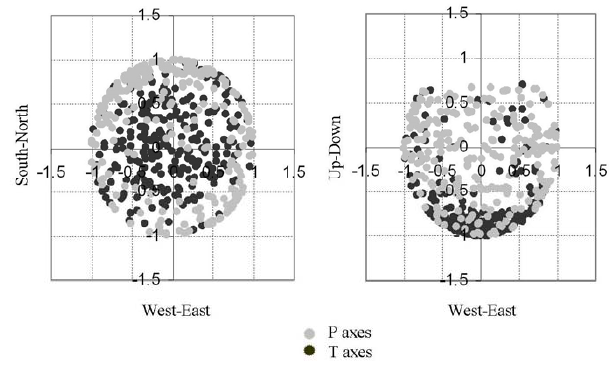
Fig. 4. Geometrical illustration of fault plane, slip direction, the Figure 4. Geometrical illustration of fault plane, slip direction, the normal direction to the fault plane. The slip normal direction to the fault plane. The slip vector is the movement vector is the movement of the hanging wall block relative to footwall block. of the hanging wall block relative to the footwall block.